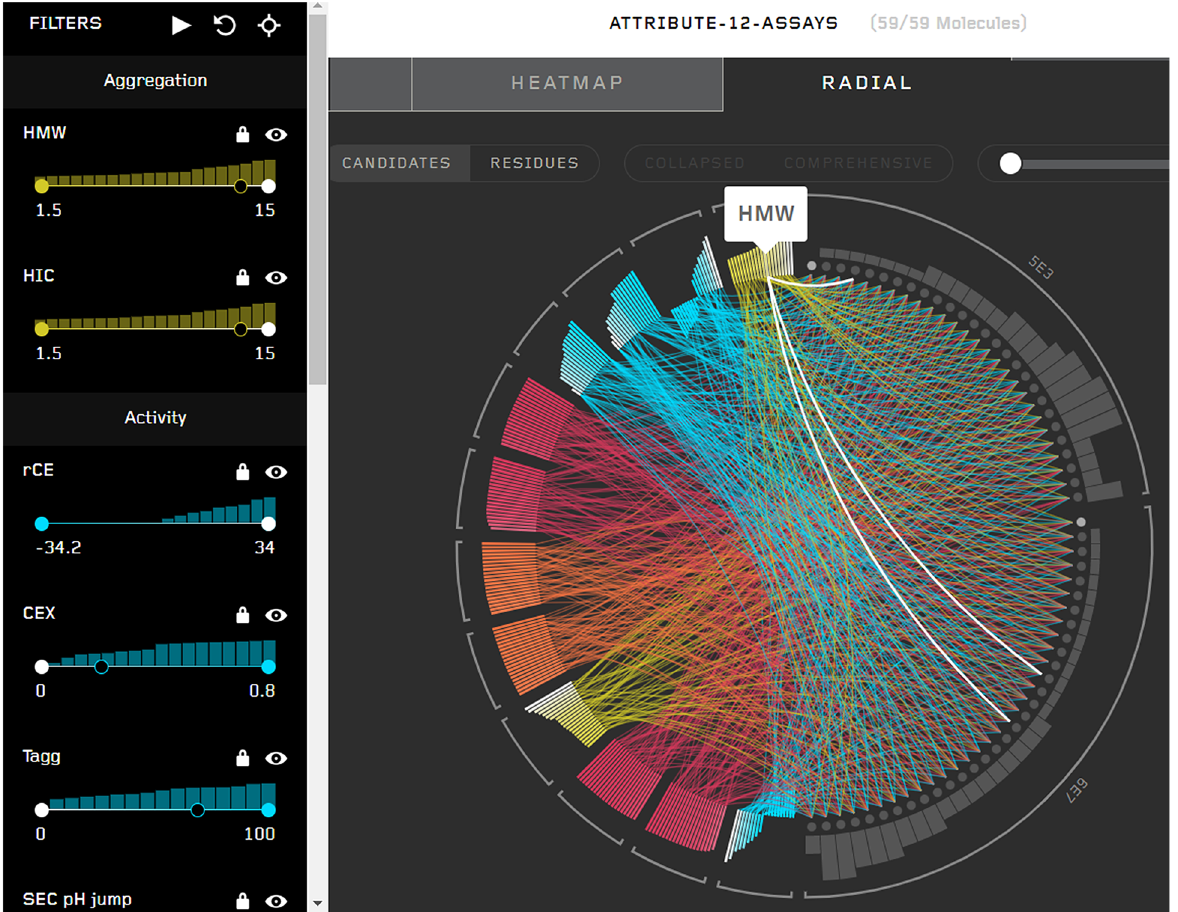
Fig. 11 Radial graph multivariate data correlation chart showing individual molecule candidate